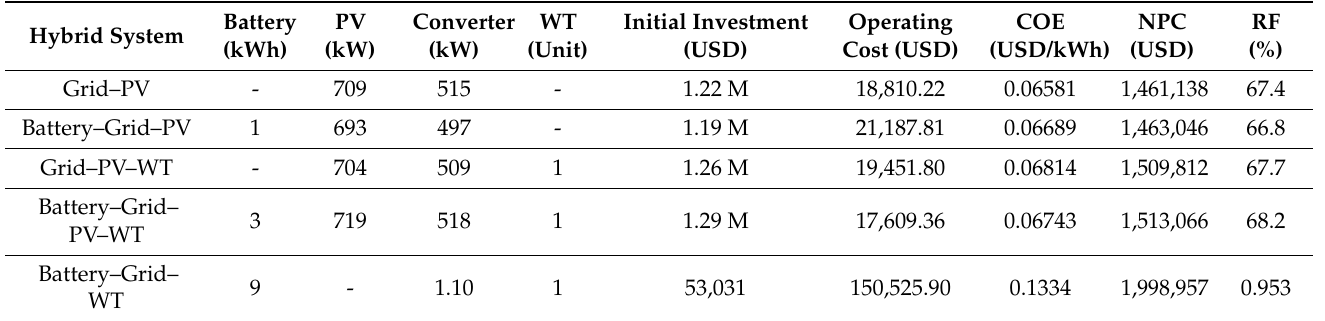
Figure 7. Monthly electric production of the various system configurations. Table 5. Economic assessments of the considered